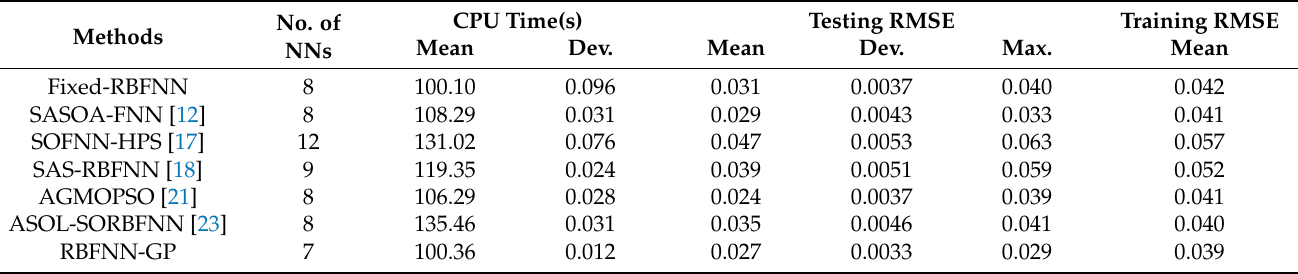
Table 1. Comparison results with other self-organizing